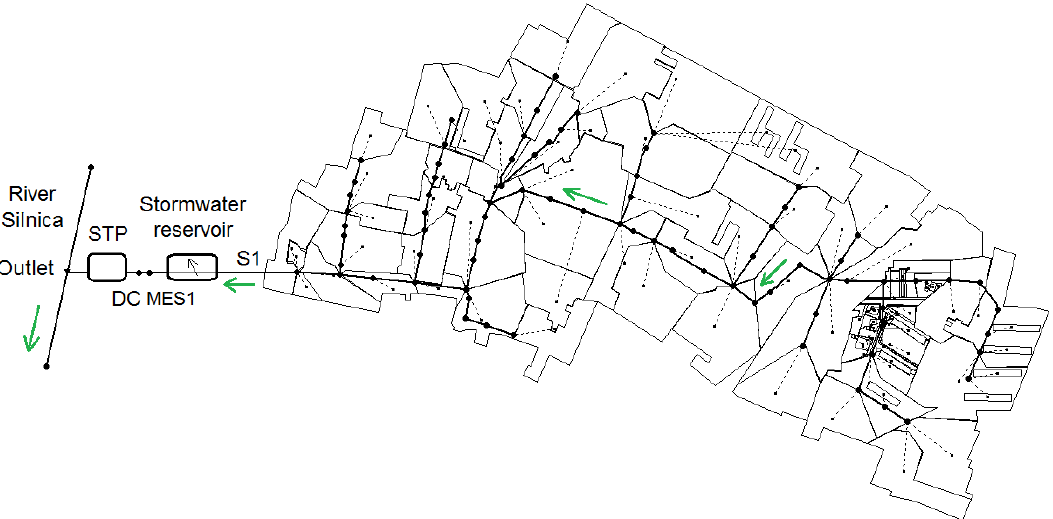
Figure 1. Location of the analyzed catchment and model diagram in Storm Water Management Model (SWMM) software.